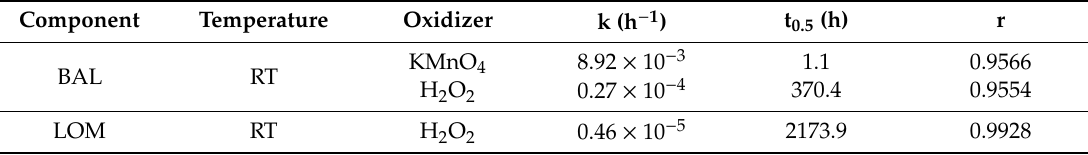
Table 3. The kinetic results of the oxidation of FQs by H 2 O 2 and KMnO 4 .